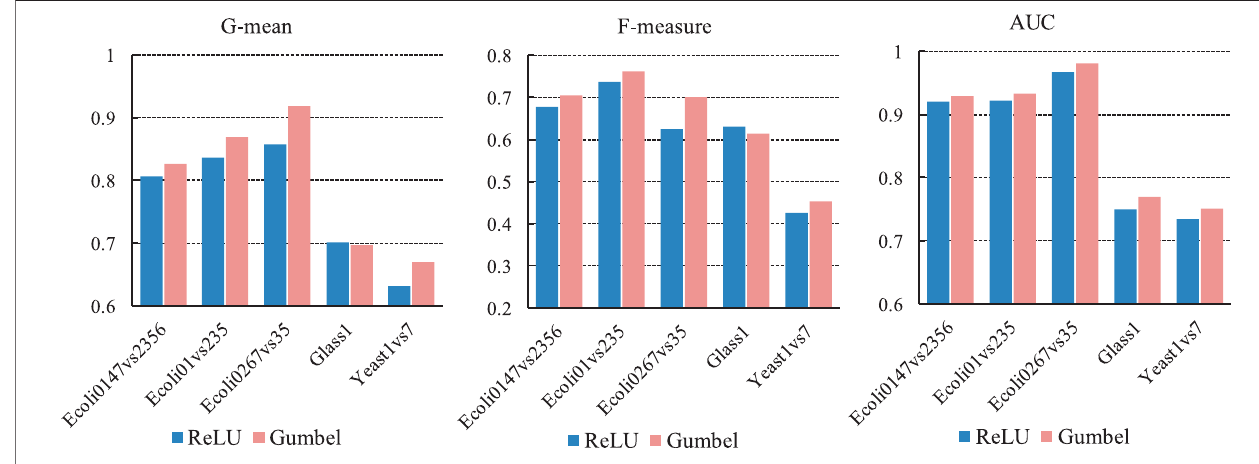
FIGURE 5 | Classi fi cation effect of DFSVM under two different activation functions.